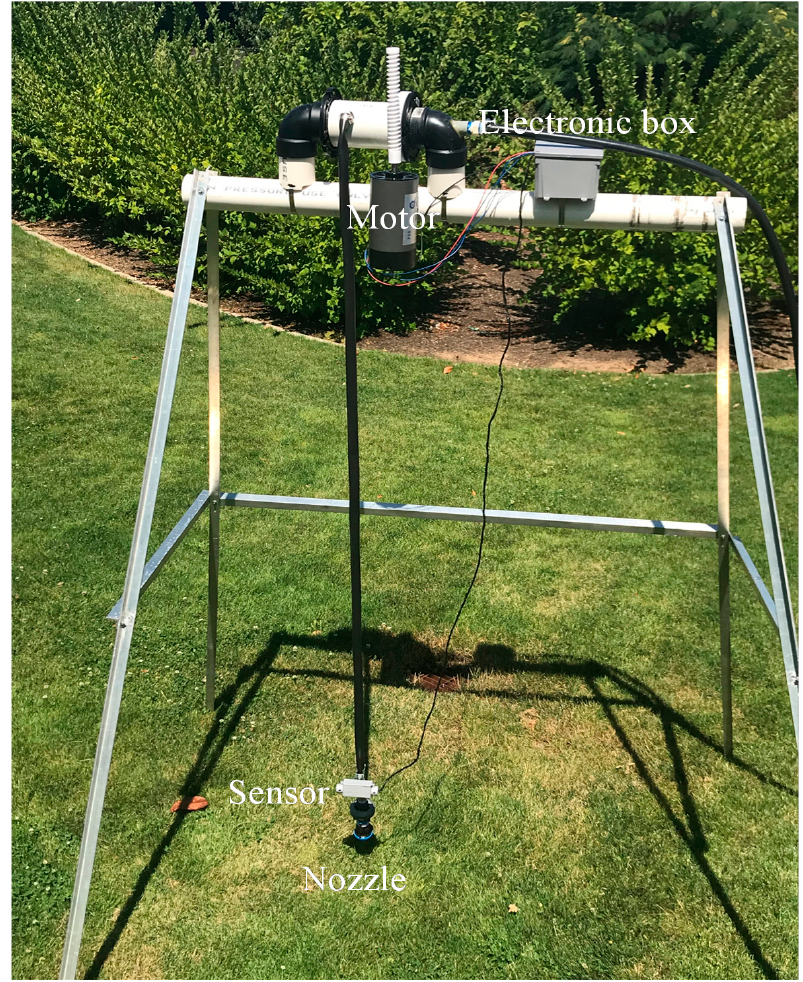
Figure 1. Snapshot for DESA designed and tested with all components to rotate hosepipe back and forth connected with an electronic board assembly with circuits.